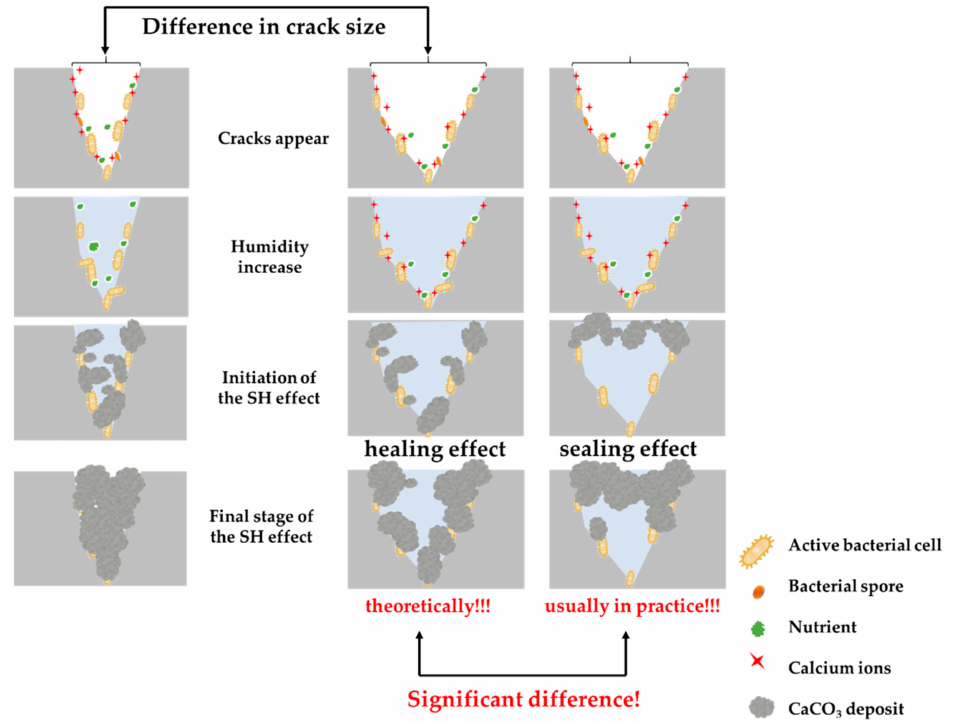
Figure 6. The difference in the SH effect depends on crack